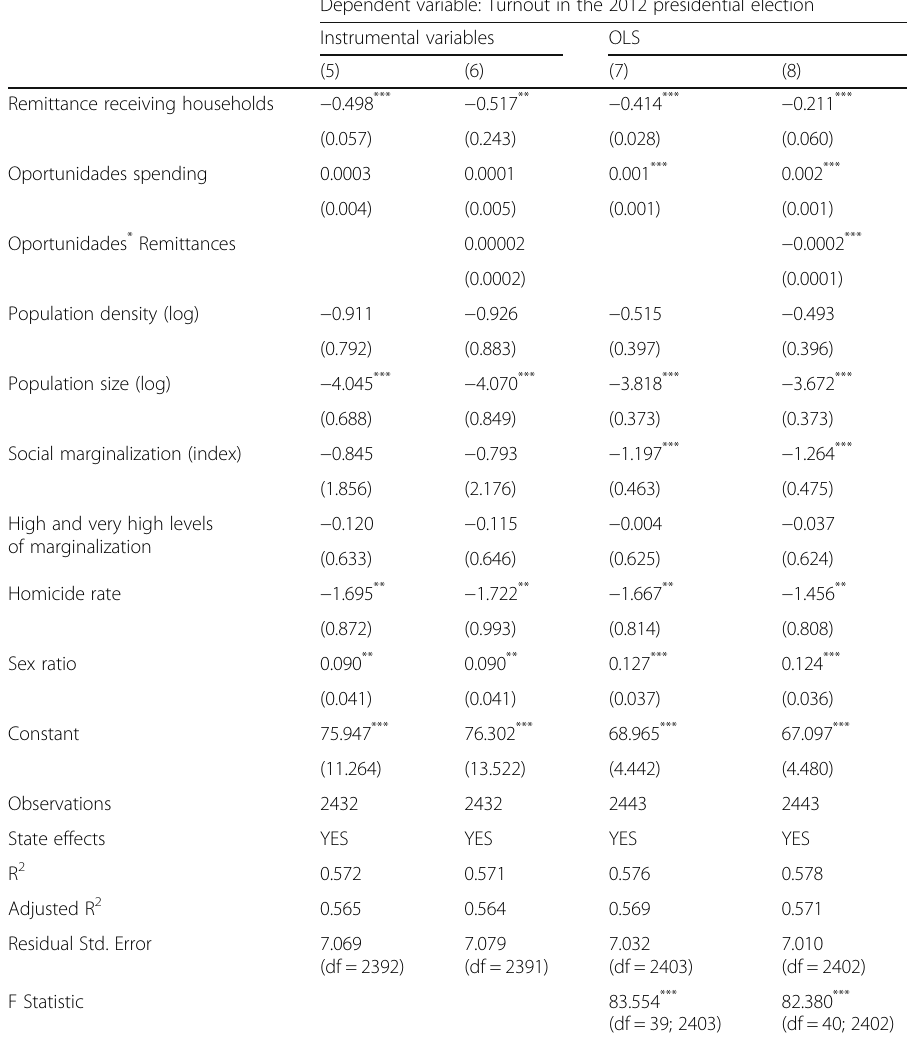
Table 4 Linear regression